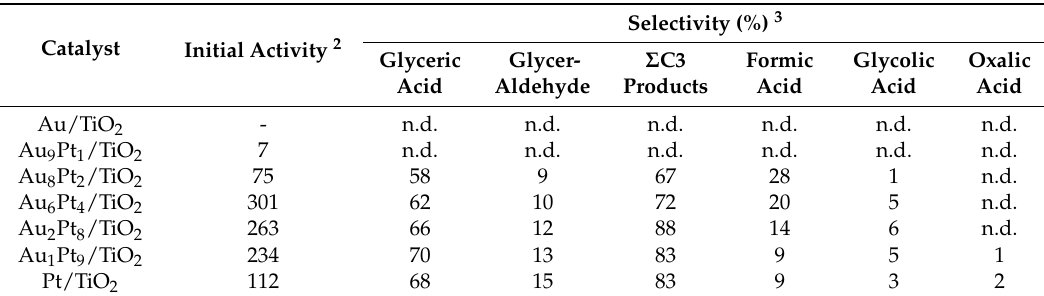
Table 3. Catalytic evaluation in the base free glycerol oxidation 1